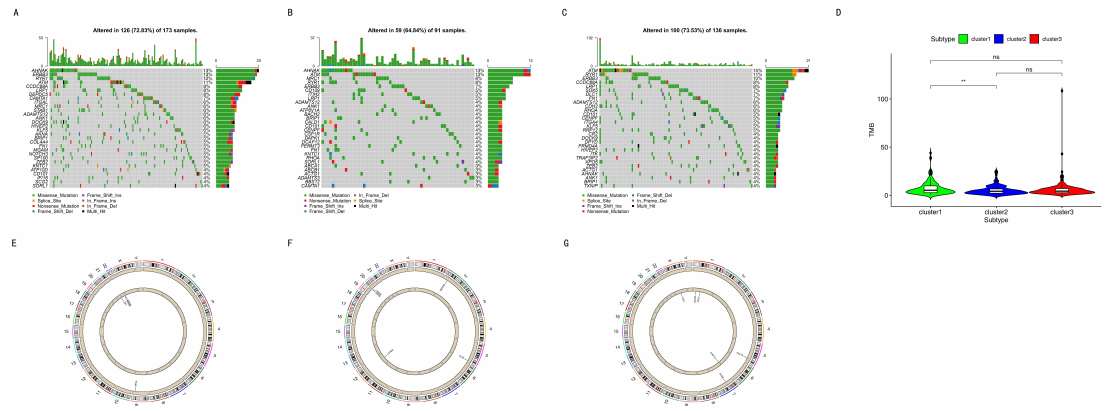
Figure 8. Mutations and CNV. ( A ) Immune-cell-associated gene mutations in cluster 1. ( B ) Immune-cell-associated gene mutations in cluster 2. ( C ) Immune-cell-associated gene mutations in cluster 3. ( D ) TMB among the three subtypes. Two asterisks indicate a p -value less than 0.01. Ns indicates no significance. ( E – G ) Immune-cell-associated gene CNVs in the three